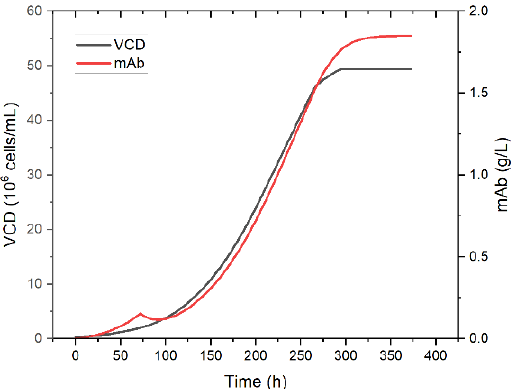
Figure 13. Simulation results of viable cell and product concentration in perfusion.